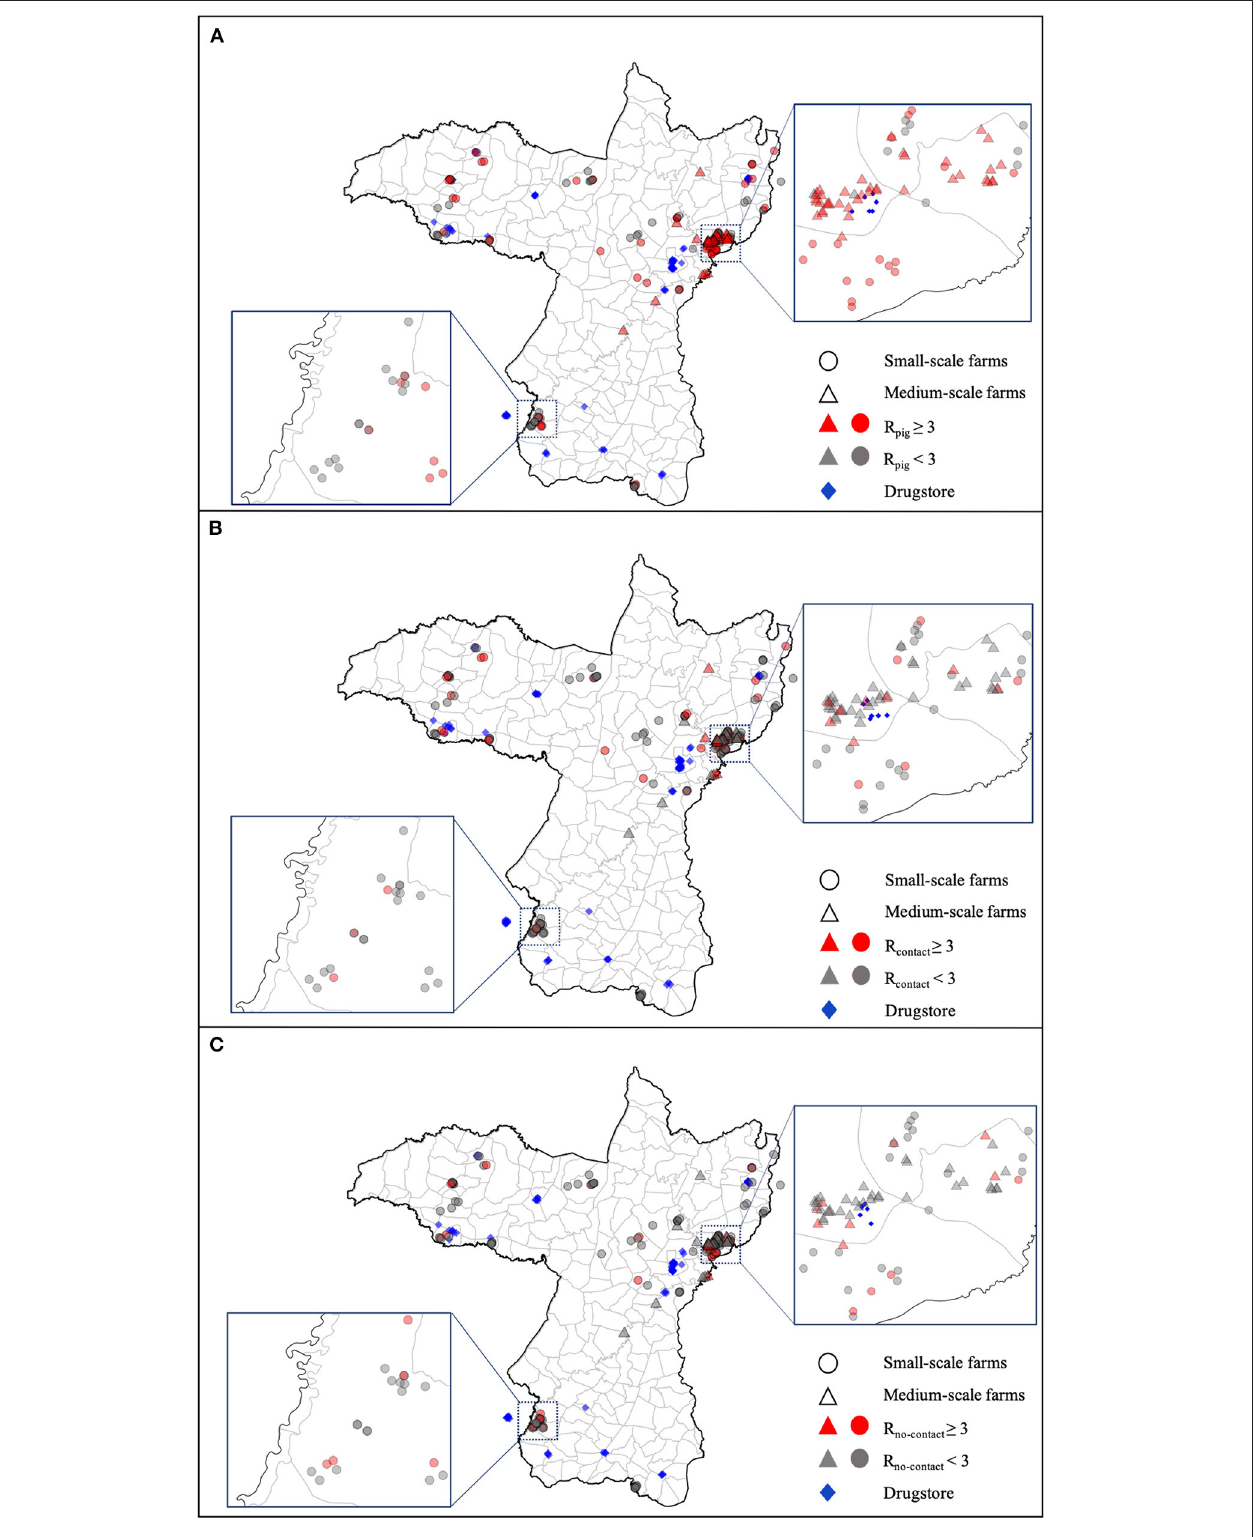
FIGURE 1 | Geographic distribution of resistance in E. coli from (A) pigs, (B) contact humans, and (C) no-contact humans in Khon Kaen. Each data point represents a farm ( n = 164). Farms with R pig , R contact , and R no − contact ≥ 3 are represented in red, and farms with R pig , R contact , and R no − contact < 3 are represented in gray. Triangles represent medium-scale farms, and circles represent small-scale farms. The location of the drugstores from which farms reported buying veterinary supplies are represented by the blue rectangles. Blue dashed squares show the zoomed view of the cluster regions.